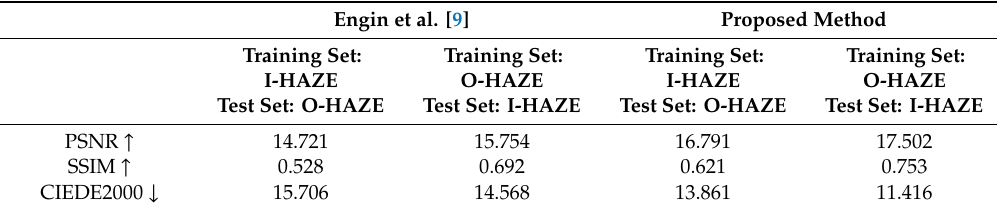
Table 3. Cross-dataset quantitative results using the I-HAZE [31] and O-HAZE [10] datasets. Engin et al. [9]